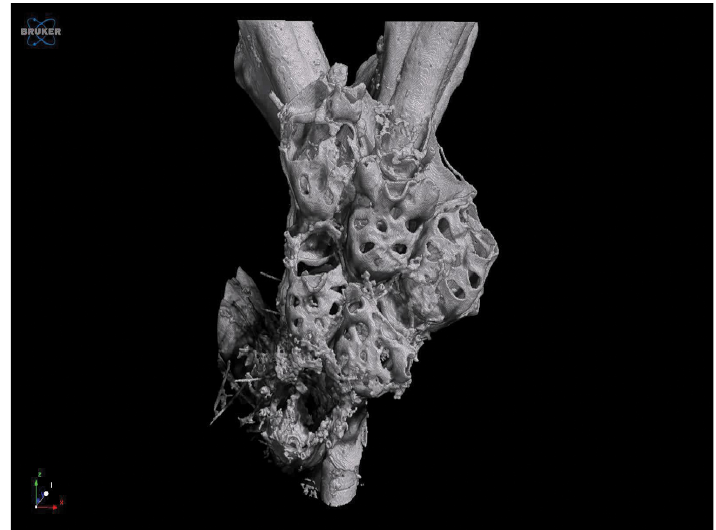
Figure 12. Close-up video of the 3D-model of Arachnopusia sp. (MNA 10491) shown in Figure 11. The width of the colony is 1.2